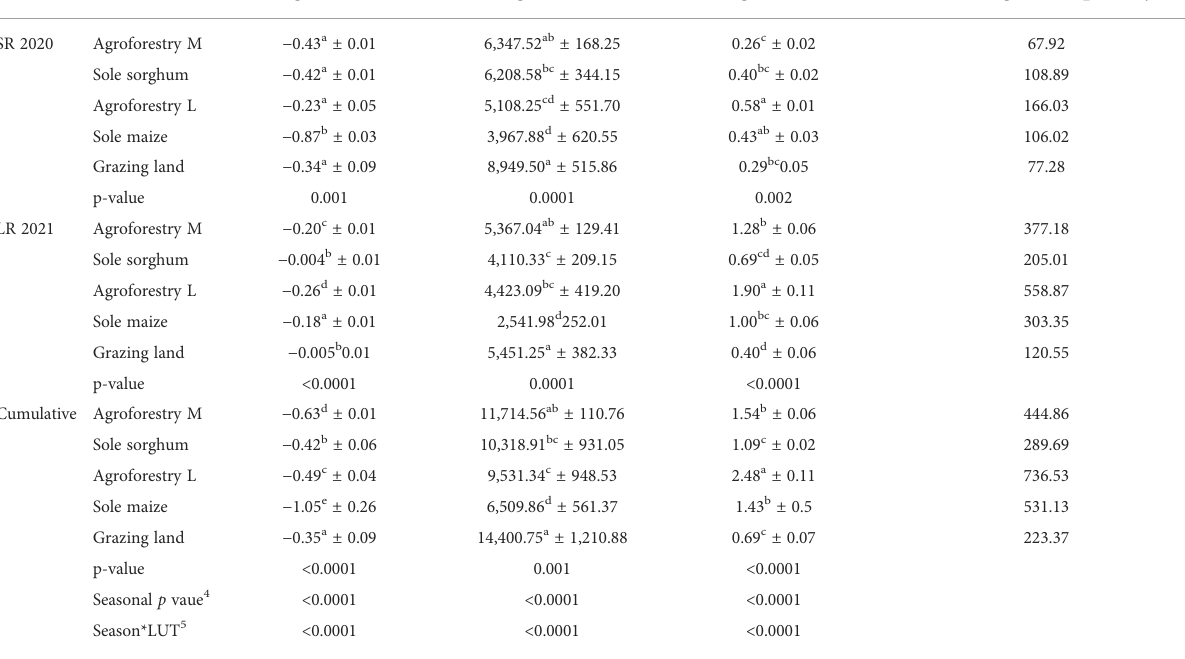
TABLE 4 Soil GHG emissions (mean ± SEM) as in fl uenced by land utilization types between July 2020 and May 2021 in Siaya County, Kenya.